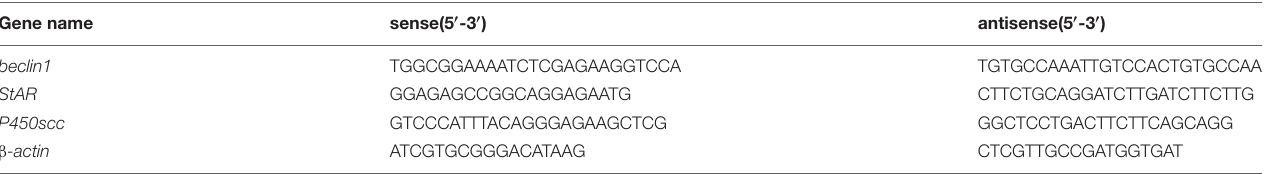
TABLE 1 | The PCR primer sequences for porcine beclin1 , StAR , P450scc , and β -actin . Gene